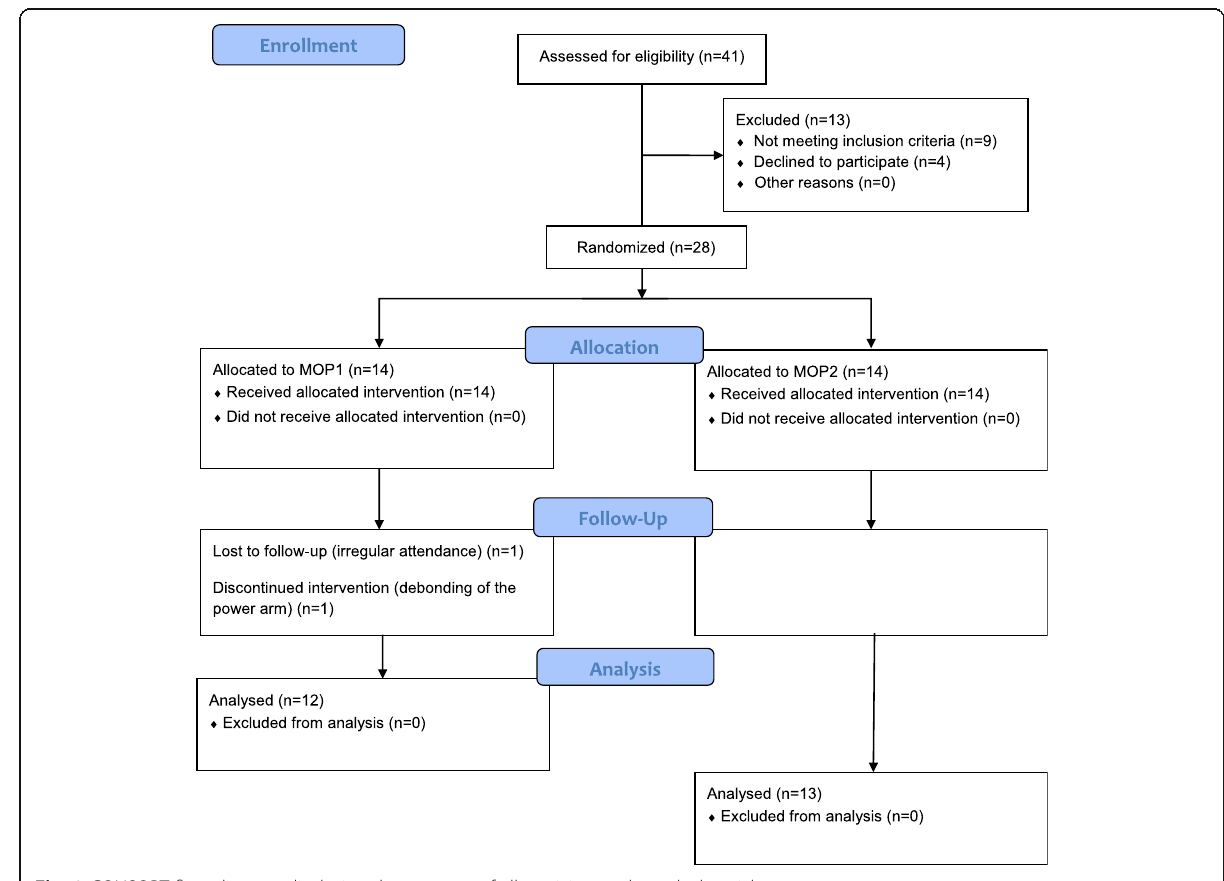
Fig. 2 CONSORT flow diagram displaying the progress of all participants through the